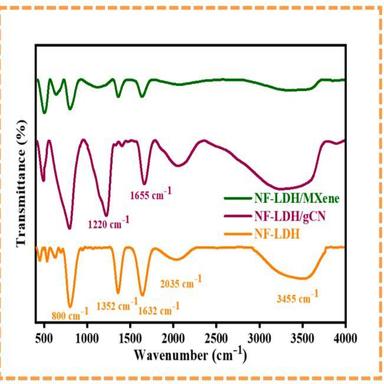
The FTIR spectrum of as-synthesized pristine NF-ldh and its composites.